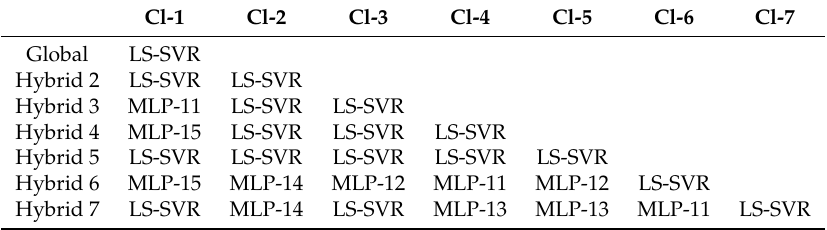
Table 3. Best algorithm per cluster in the model to predict the power at 9:00.